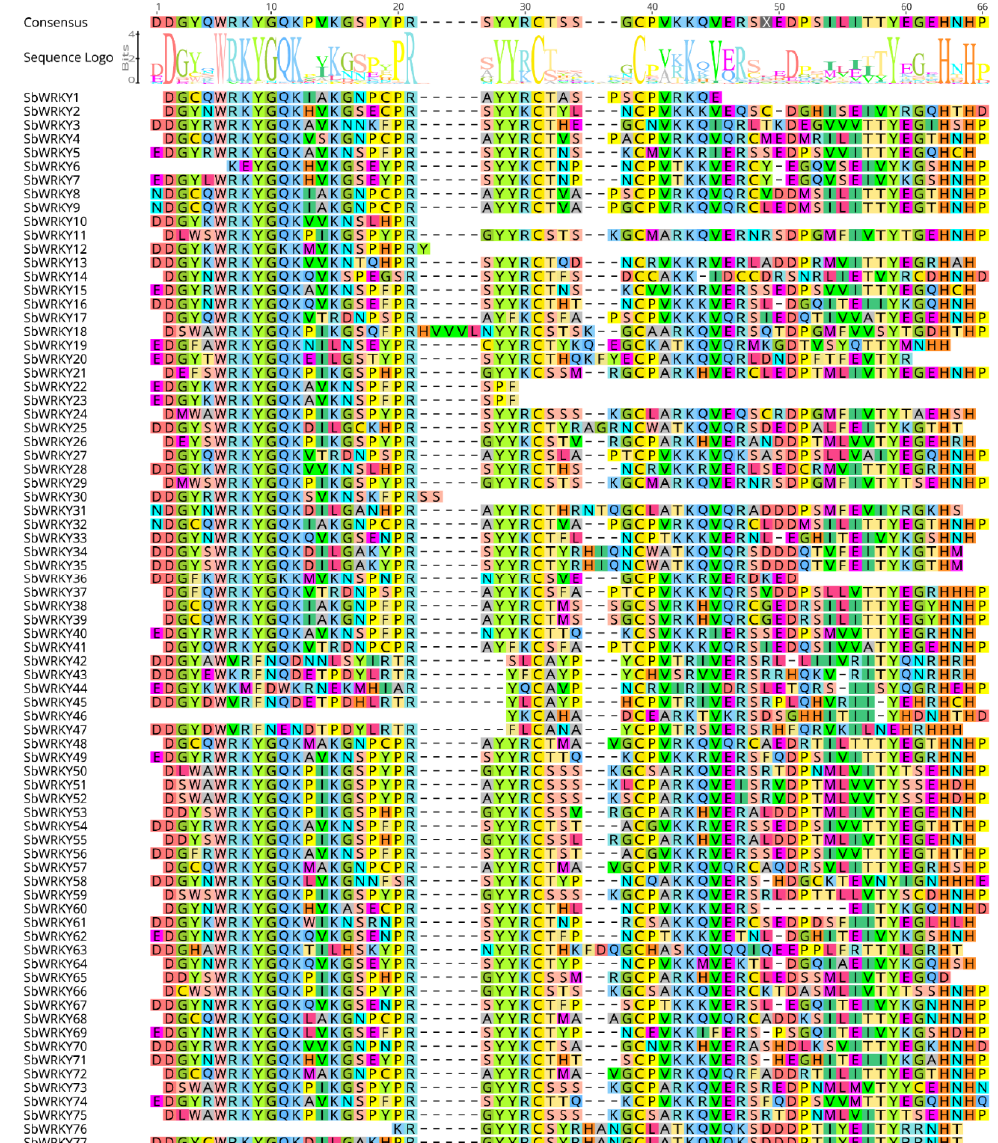
Figure 2. Multiple sequence alignment of the WRKY domain from SbWRKYs. The shading in dif ‐ ferent shapes and colors indicate the same and conserved amino acid residues, respectively.